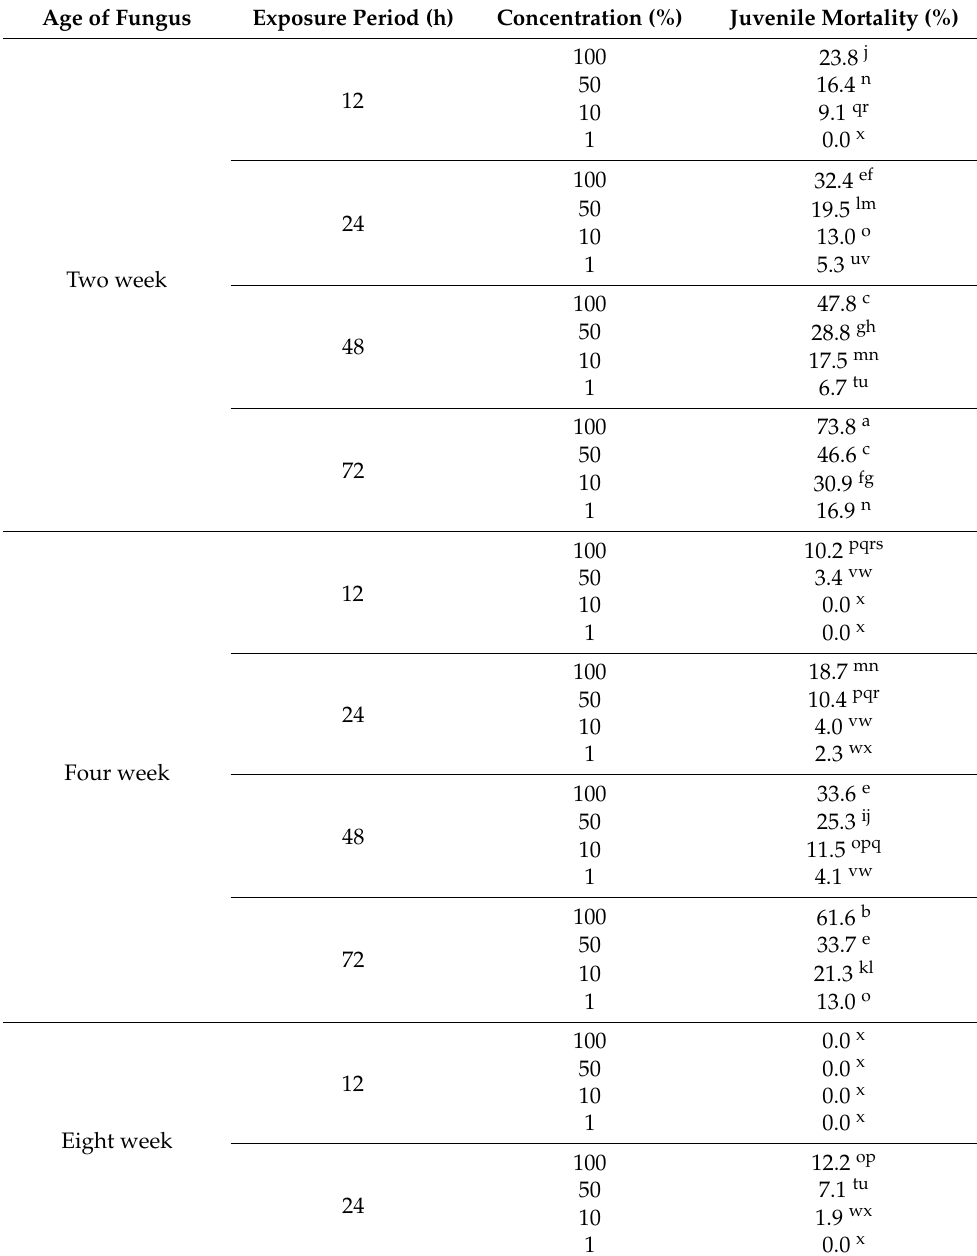
Effect of different stages of stipe of Ganoderma lucidum on juvenile mortality of Meloidogyne incognita . Age of Fungus Exposure Period